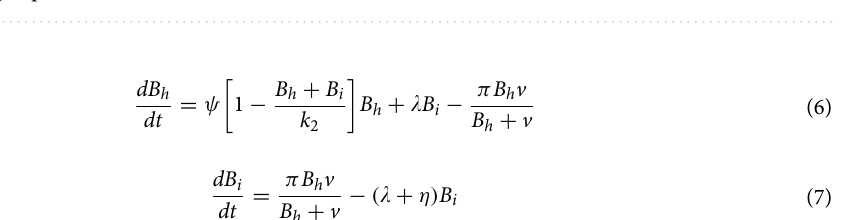
Table 1. Meaning of parameters in the HBV